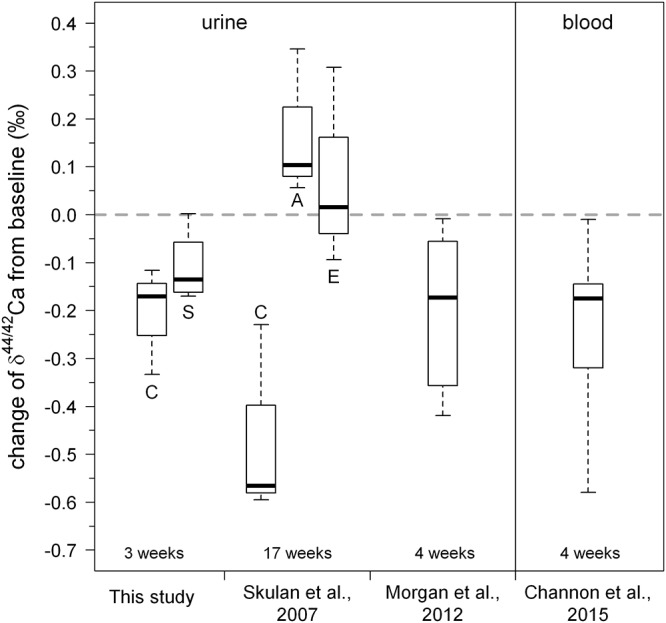
Boxplot of changes in urinary Ca isotopic composition obtained during our study. For comparison, the data of Skulan et al. (2007); Morgan et al. (2012), and Channon et al. (2015) are also shown. Overall, the changes observed in the study are in good agreement with those found in previous studies. A small but statistically insignificant difference between the control group (C) and the KHCO3 supplemented group (S) can be seen. Letters for the Skulan et al. dataset correspond to: (C) control group, (E) exercise group, and (A) alendronate supplemented group.